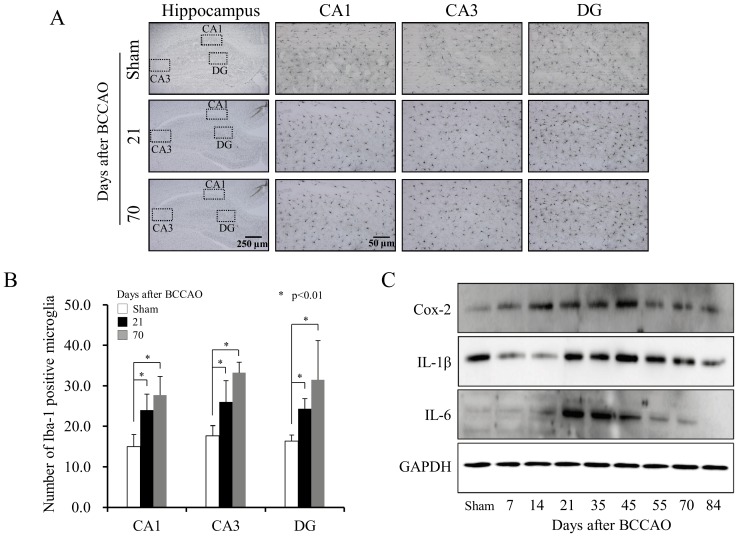
Altered expression of inflammatory proteins in the hippocampus after occlusion of the bilateral common carotid artery (BCCAO).(A) The hippocampus was immunostained with Iba-1 at 21 and 70 days after BCCAO in rats and (B) the number of Iba-1 positive microglia was quantified in each region (0.03 mm2) of the hippocampus (CA1, CA3) and the dentate gyrus (DG). The values shown are the mean ± SD of groups of 8 rats. The groups were compared using Student’s t-test, with p-values<0.01 being considered significant. (C) The protein expression of cyclooxygenase-2 (Cox-2), interleukin (IL)-1β and IL-6 in the hippocampus was measured in a time-dependent manner in rats with BCCAO.